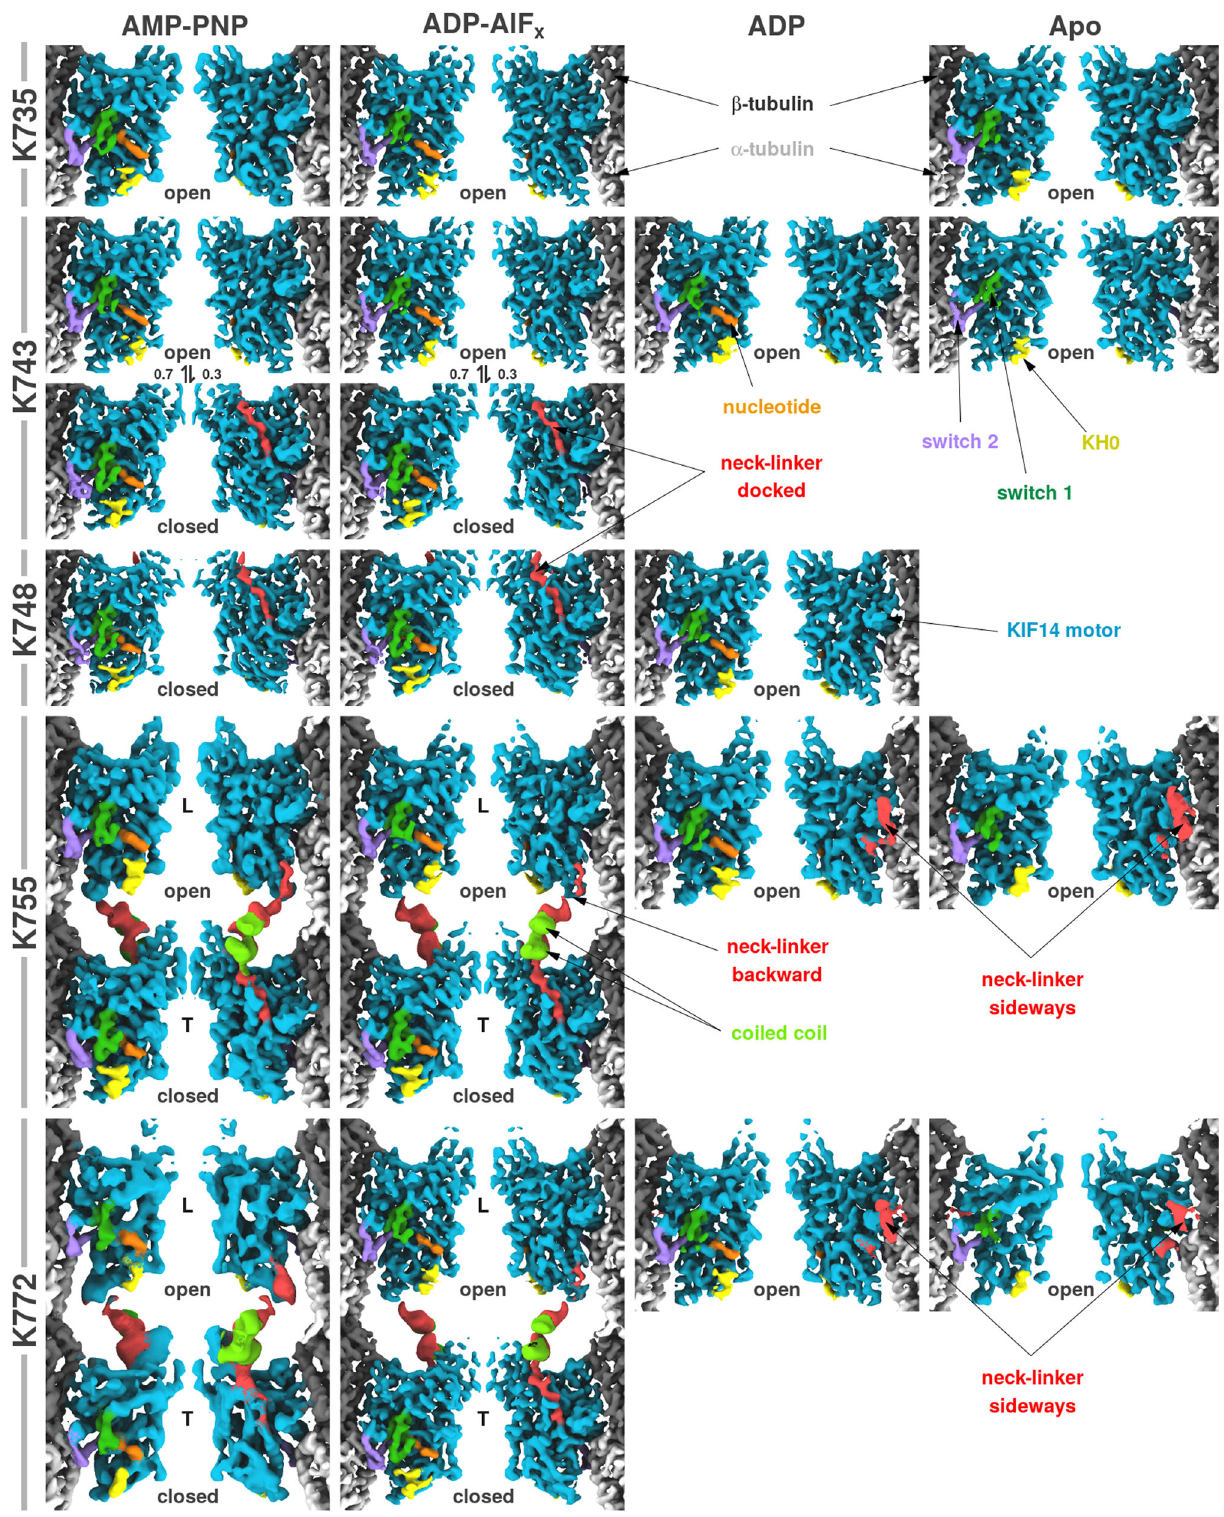
The con fi guration of the motor domain around the nucleotide phosphate groups in the MT-K748-ANP/AAF structures is similar to the closed ATP-hydrolysis-catalytic con fi guration, fi rst observed in the crystal structure of the kinesin-5 EG5 in the